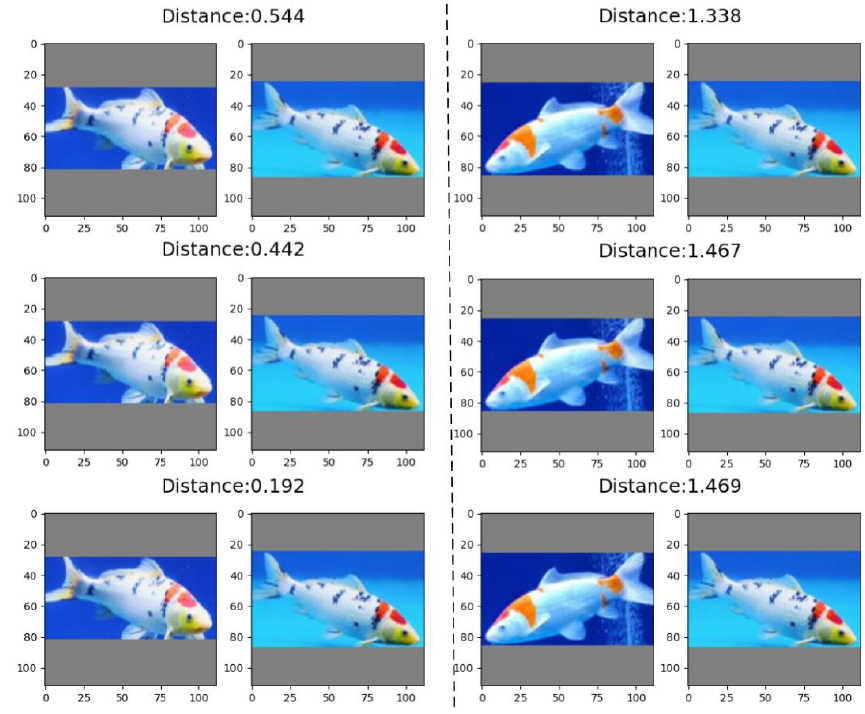
Figure 13. Examples of fish individual recognition visualization results.